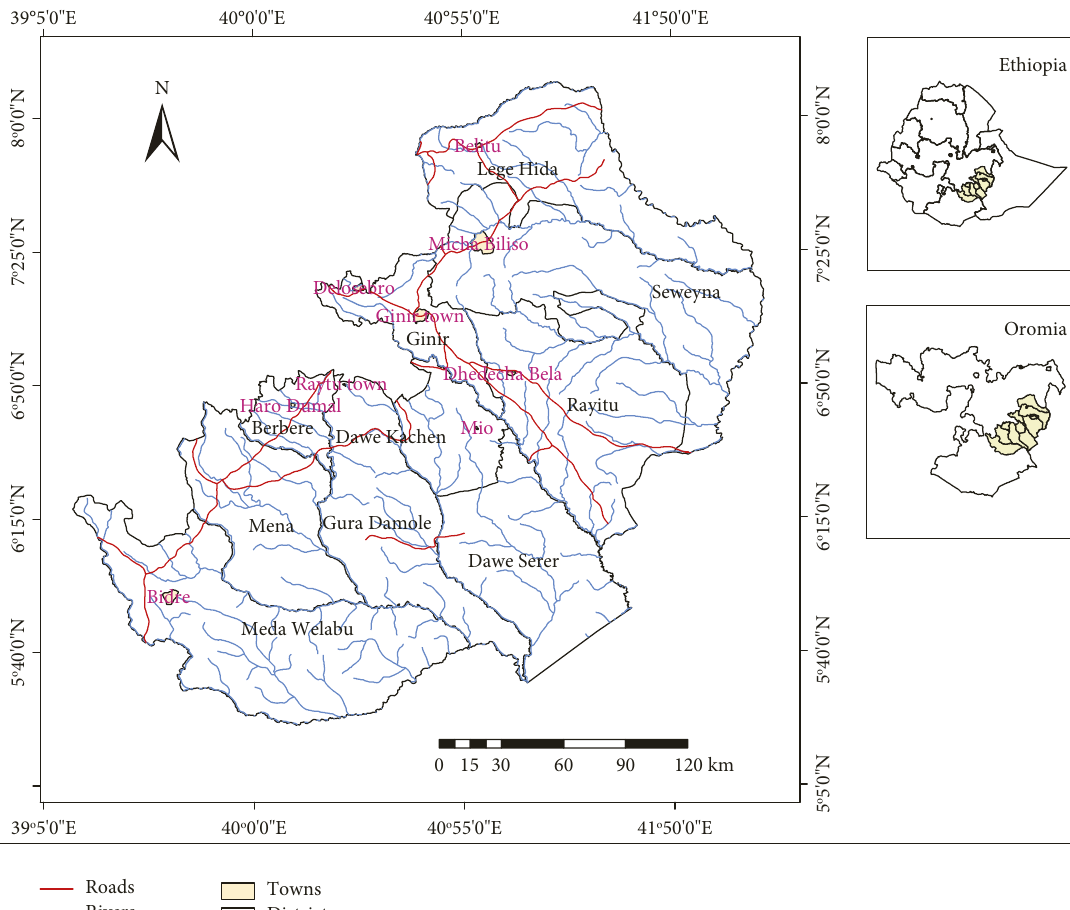
Figure 1: Location of the study